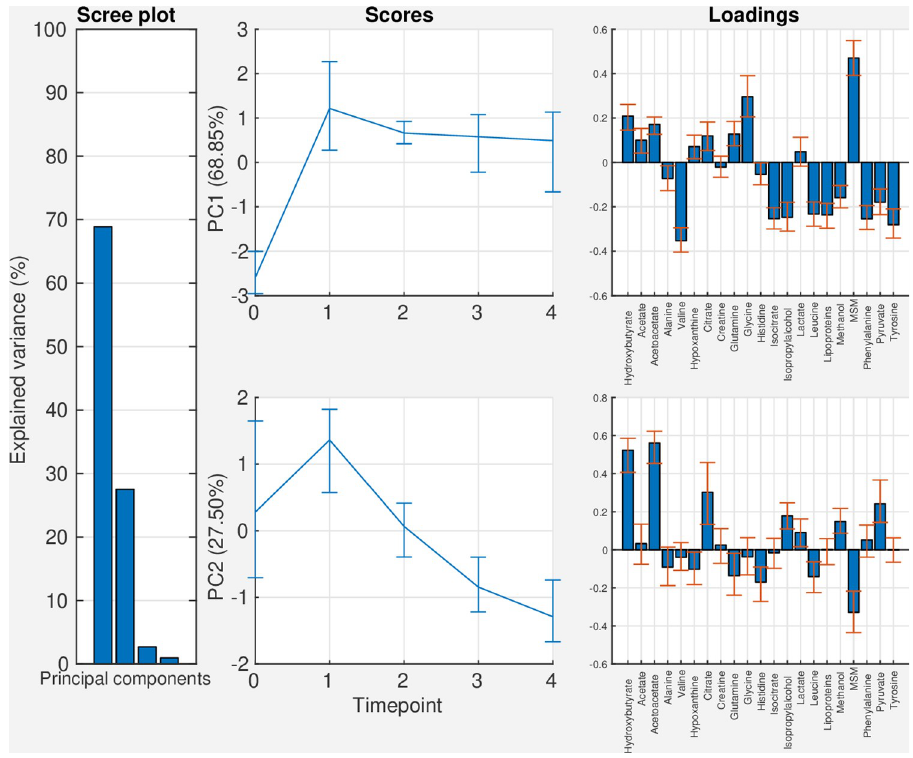
Fig 3. Scree-, score-, and loading plots for the effect matrix for time in the bariatric surgery data. Abbreviations: PC: principal component, MSM: methylsulfonylmethane.